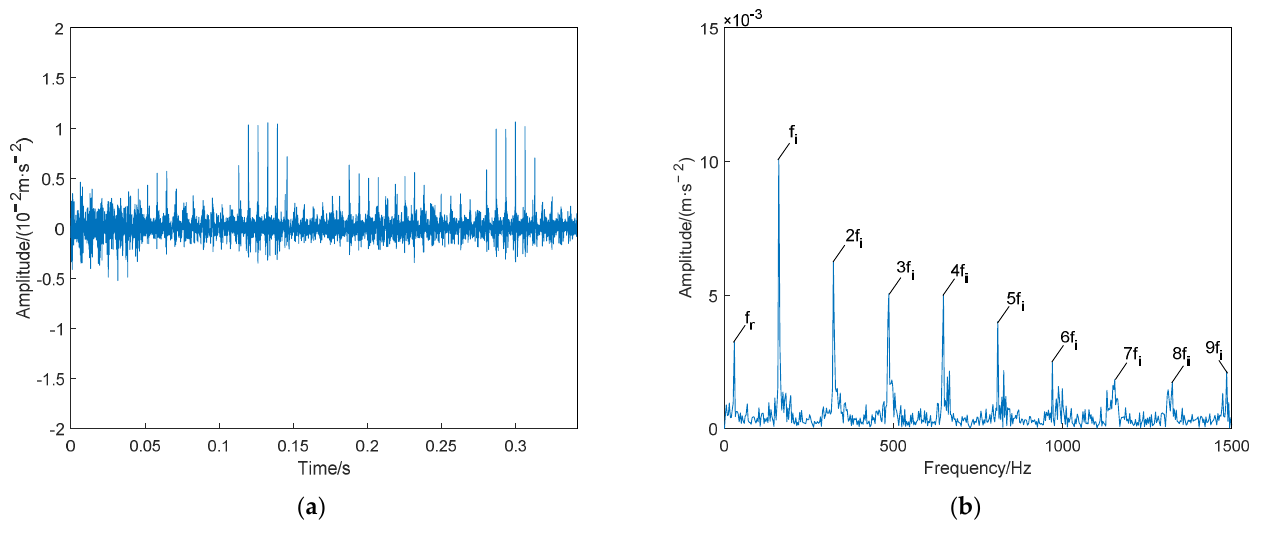
Figure 19. Time-domain waveform and envelope spectrum after MCKD processing: ( a ) time-do- main graph after MCKD processing; ( b ) envelope spectrum after MCKD processing.